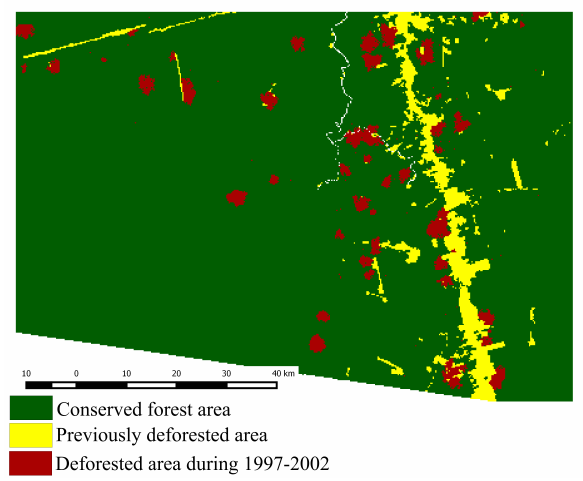
Figure 5: Simulated LUCC map (1997-2002) using the CA cali- brated by the genetic algorithm. Previously deforested area refers to forest area cleared before 1997